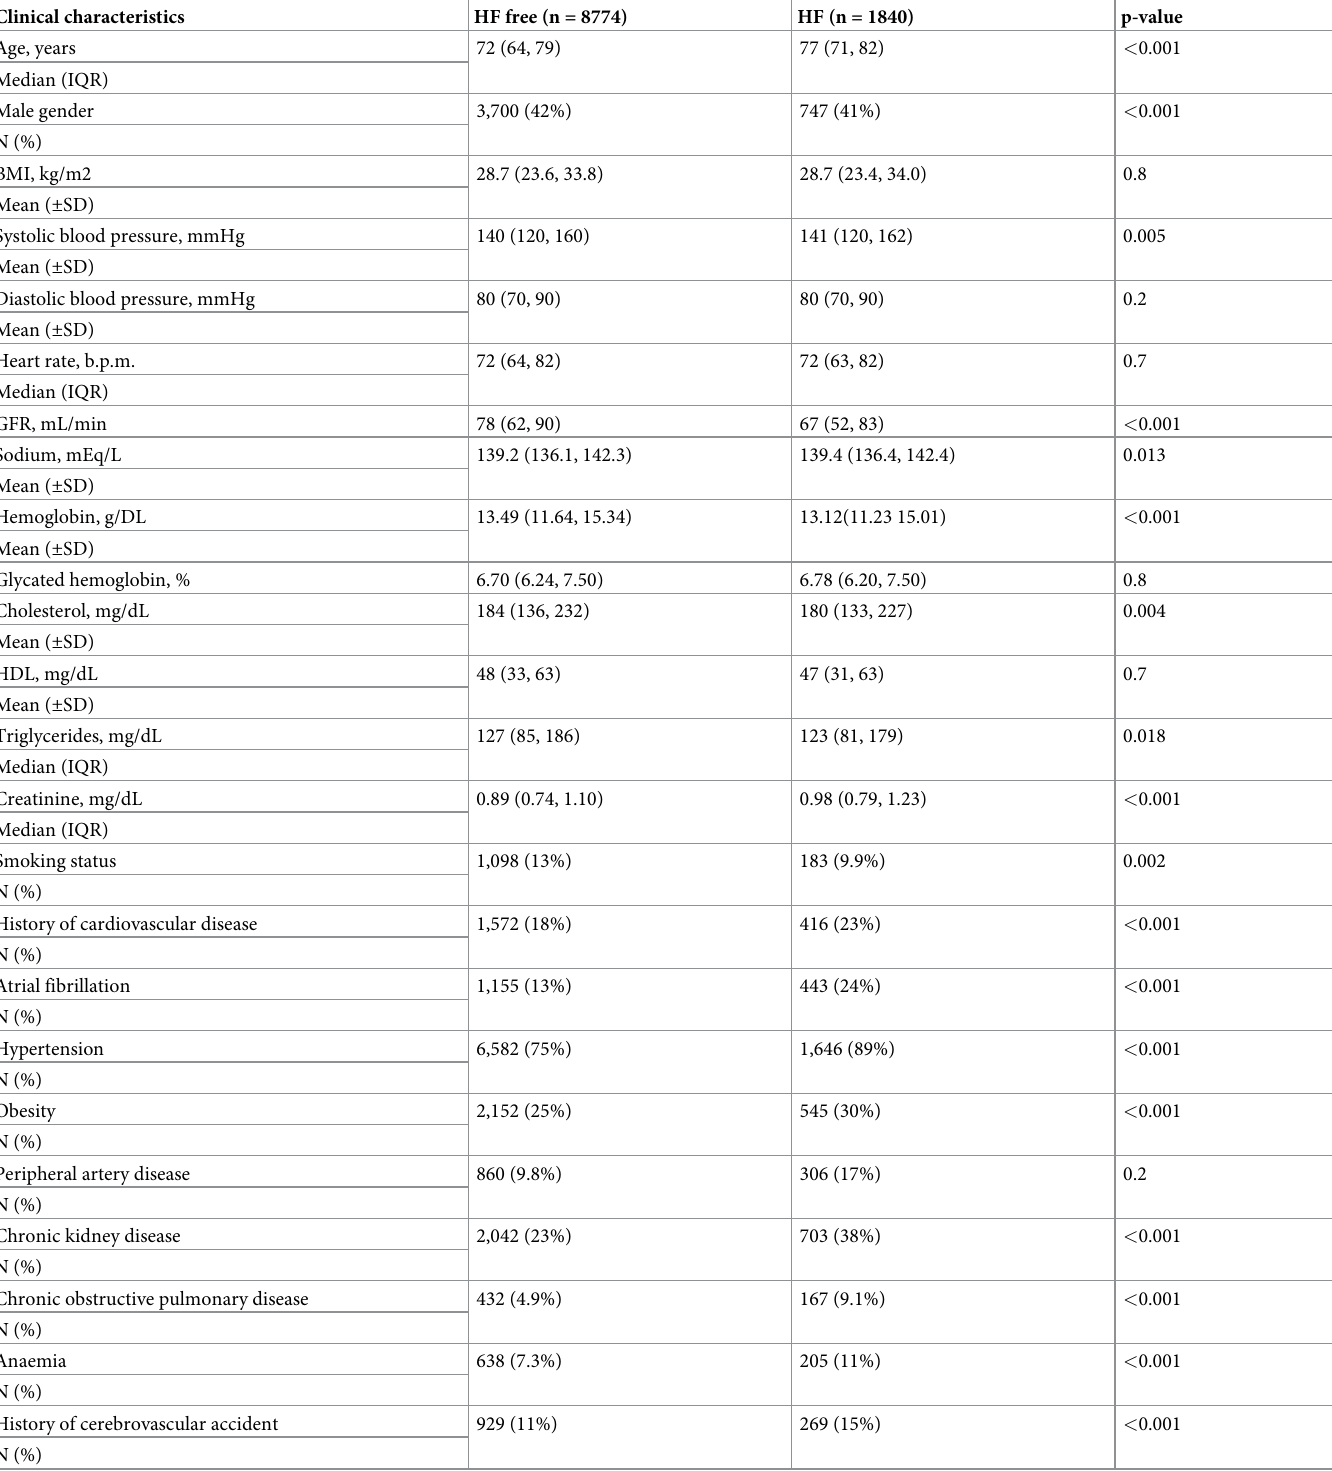
Table 1. Characteristics of the cohort separately for individuals free from HF and individuals that have developed HF. GFR was estimated using the EPI-CKD for- mula. History of cardiovascular disease includes stroke and myocardial infarction. SD = standard deviation; IQR = interquantile range; RASi = Renin–angiotensin system inhibitors; MRA = Aldosterone receptor